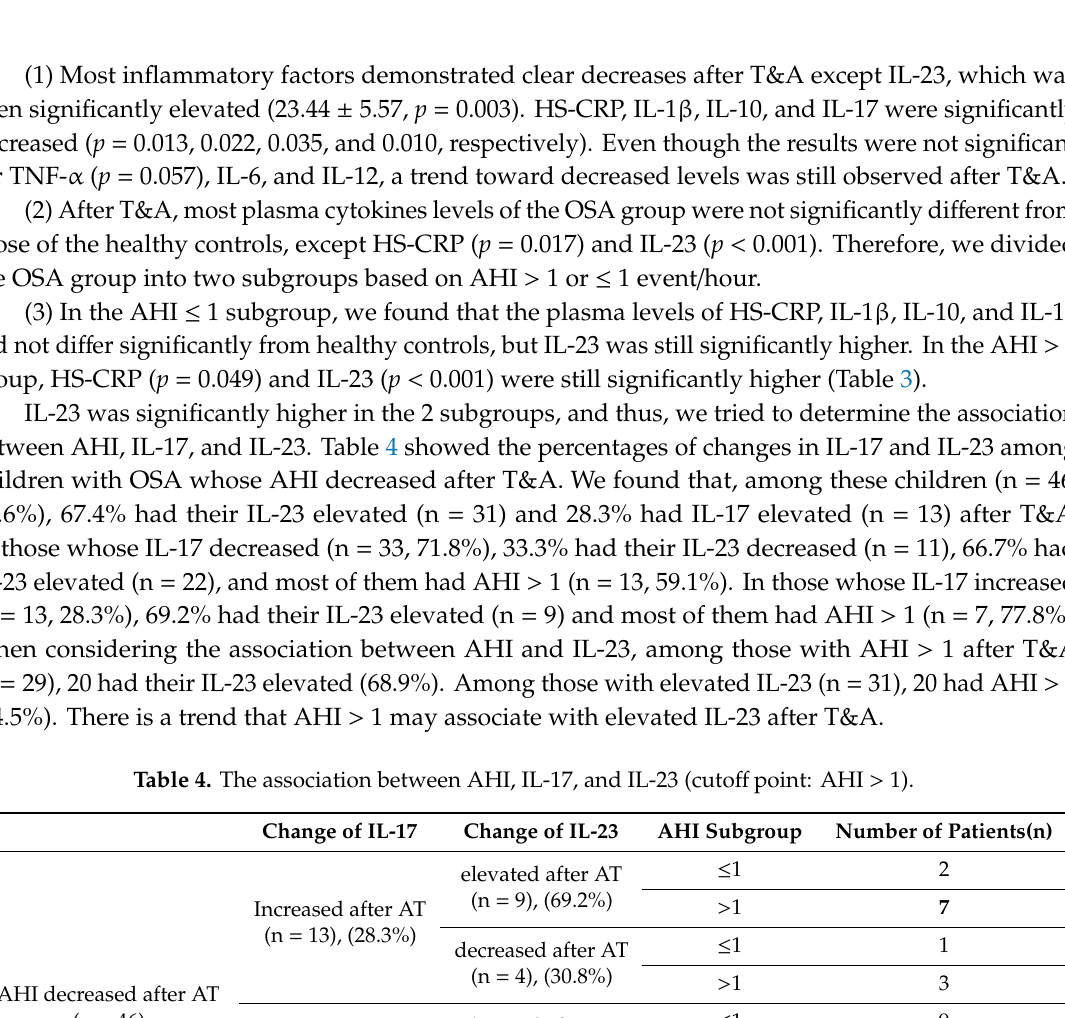
≤ 1 2 > 1 7 ≤ 1 1 > 1 3 ≤ 1 9 > 1 13 ≤ 1 5 > 1